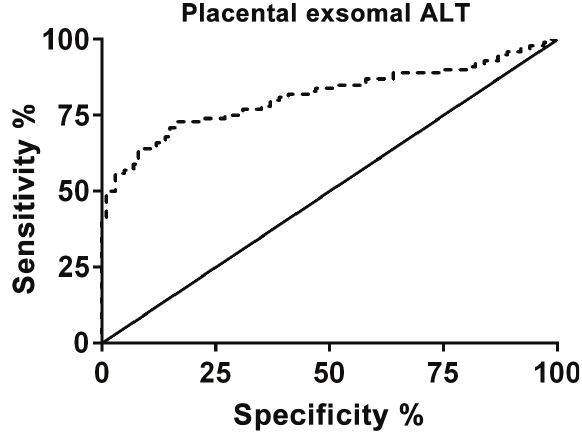
Fig. 2. Diagnostic values of placental exosomal levels of ALT in healthy pregnant participants and ICP patients were analysed by receiver operating characteristic curves. ALT, alanine aminotransferase; ICP, intrahepatic cholestasis of